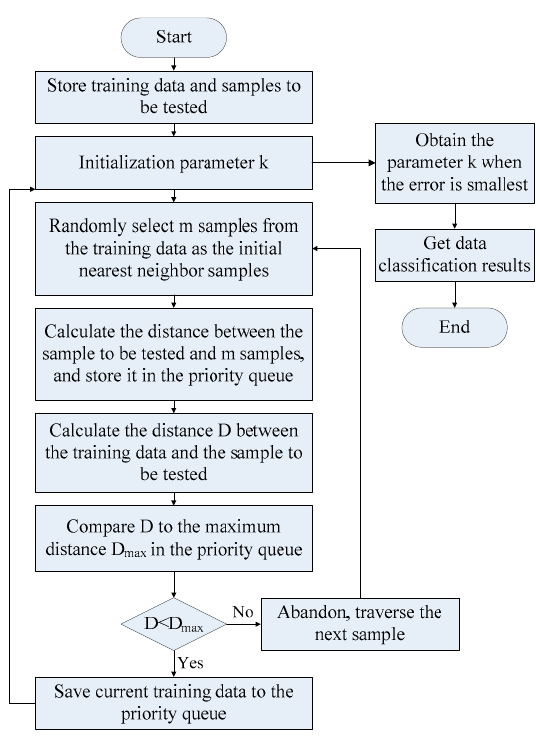
Figure 12. Flow chart of k nearest neighbor.